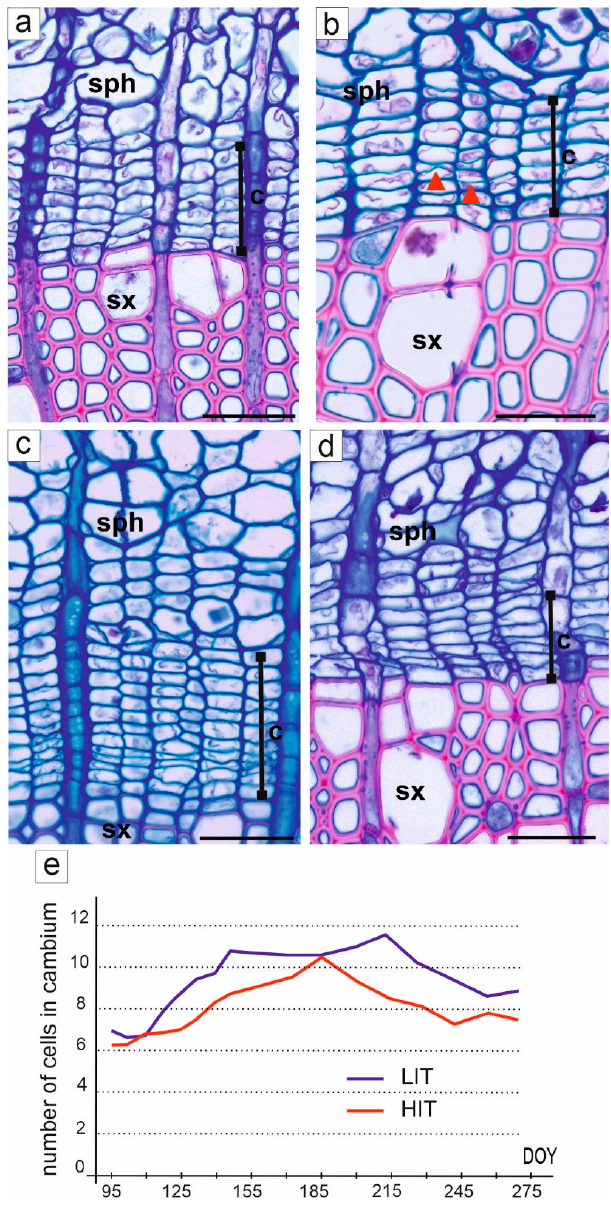
Figure 3. Intra-annual changes in cambium activity of Aesculus hippocastanum trees under the impact of horse chestnut leaf miner. ( a – d ) transverse sections; ( a ) dormant cambium (denoted by bracket) with 5-8 cells located in radial files at the beginning of April; ( b ) the onset of cambium activity in the middle of April, periclinal divisions in cambial cells are visible (arrowheads); ( c ) the peak of cambium activity with 11–12 cells in radial rows in July; ( d ) cessation of cambium activity characterised by a lack of periclinal divisions and a decrease in the number of cells in radial rows; shown in September; ( e ) changes in the mean number of cambial cells during the growing season (DOY —day of the year) showing the difference between lightly (LIT) and heavily infested (HIT) tress; the mean number of cambial cells increased in both groups of trees in April, which coincides with the beginning of divisional activity of the meristem; the decrease in cell number was determined in the middle of July in HIT, whereas in LIT it was in August. The microphotographs are taken from one LIT to show the changes observed during the season. c cambium, sph—secondary phloem; sx—secondary xylem. Scale bars 50 μ m.